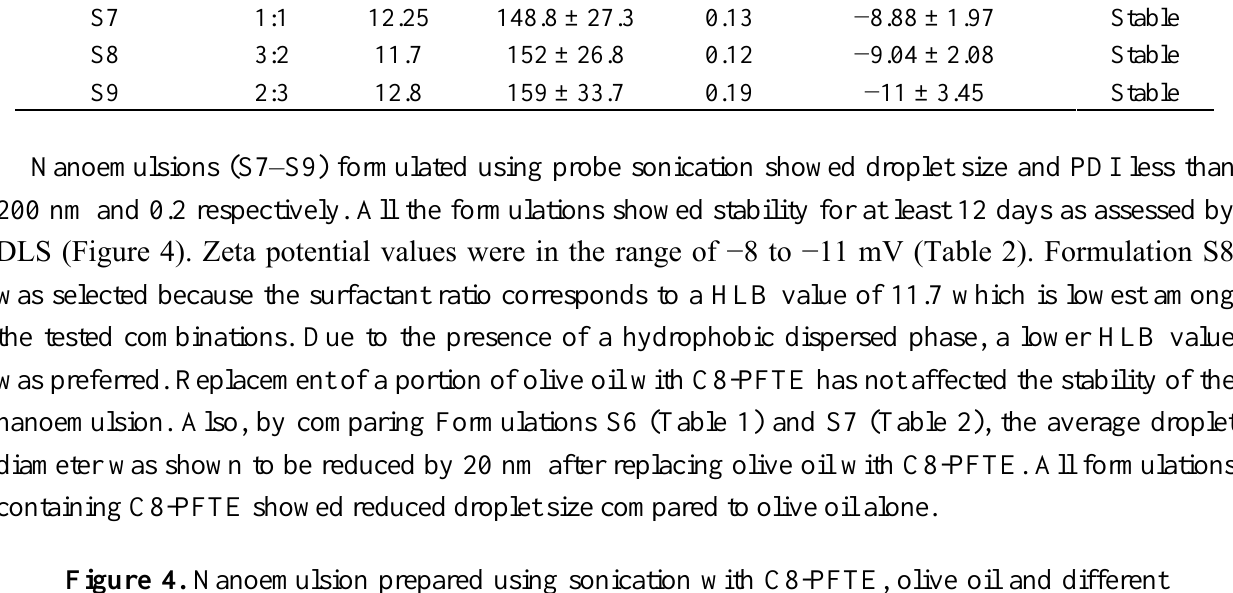
Figure 4. Nanoemulsion prepared using sonication with C8-PFTE, olive oil and different ratio of Pluronic ® P123/P105 at 3% w/v. The error bars represent the half width of polydispersity index